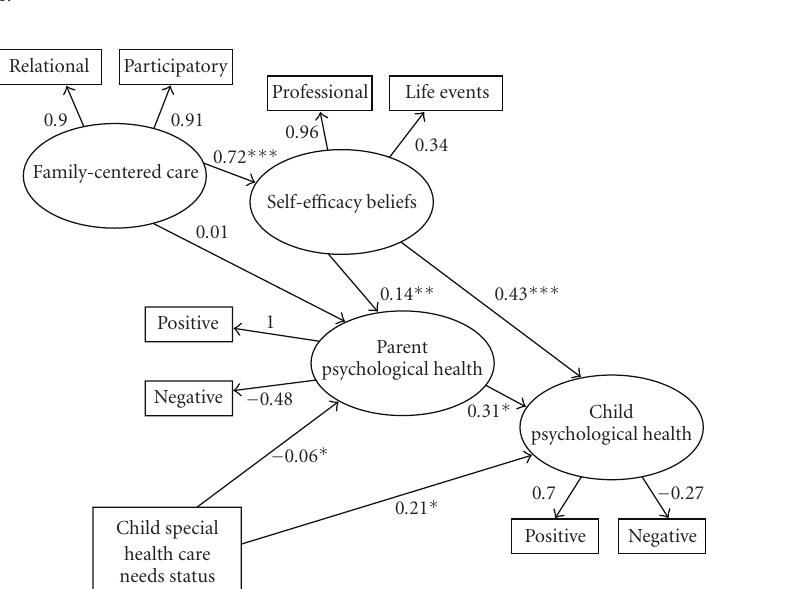
Figure 2: Structural equation model results for the e ff ects of family-centered care, self-e ffi cacy beliefs, and child special health care needs on parent and child psychological health (MODEL I). (Note: the significance levels of the path coe ffi cients are influenced by the standard errors for those metrics and are the reason why larger coe ffi cients sometimes have smaller P -values.) ∗ P < . 01, ∗∗ P < . 001, ∗∗∗ P < .